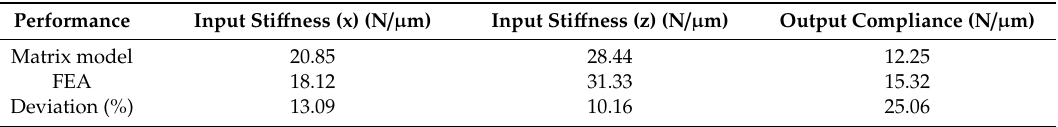
Table 4. Performances evaluated by analysis model and finite element analysis (FEA)